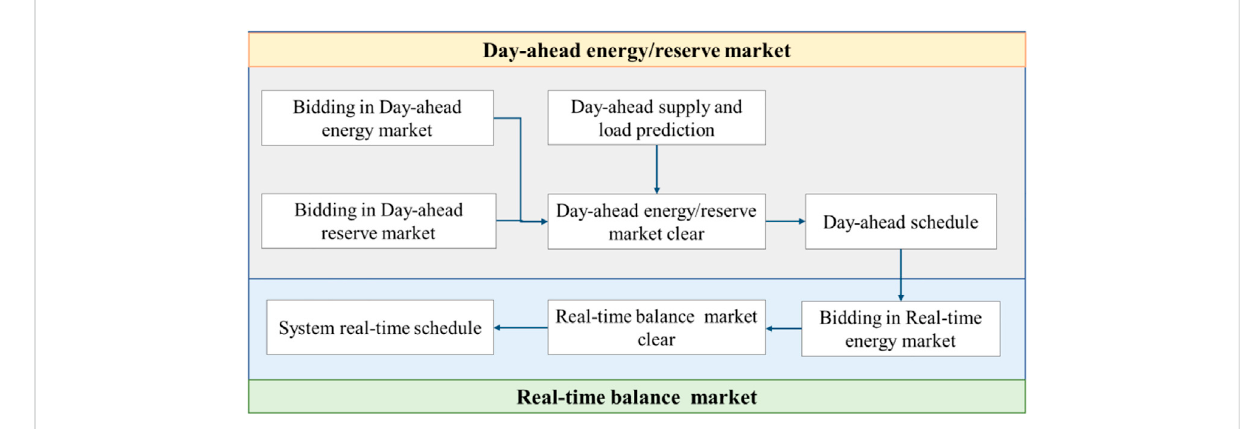
FIGURE 1 The trading framework of muti-stage